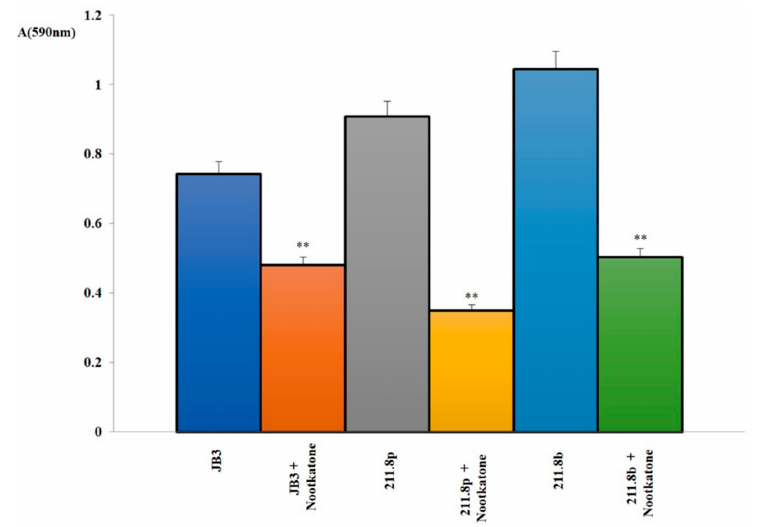
Figure 5. MTT assay performed on the 3 different species of the investigated microalgae either not treated or after treatment with nootkatone (1 g/L, 3 days). The samples were analyzed at 590 nm. ** p < 0.05 ** p <